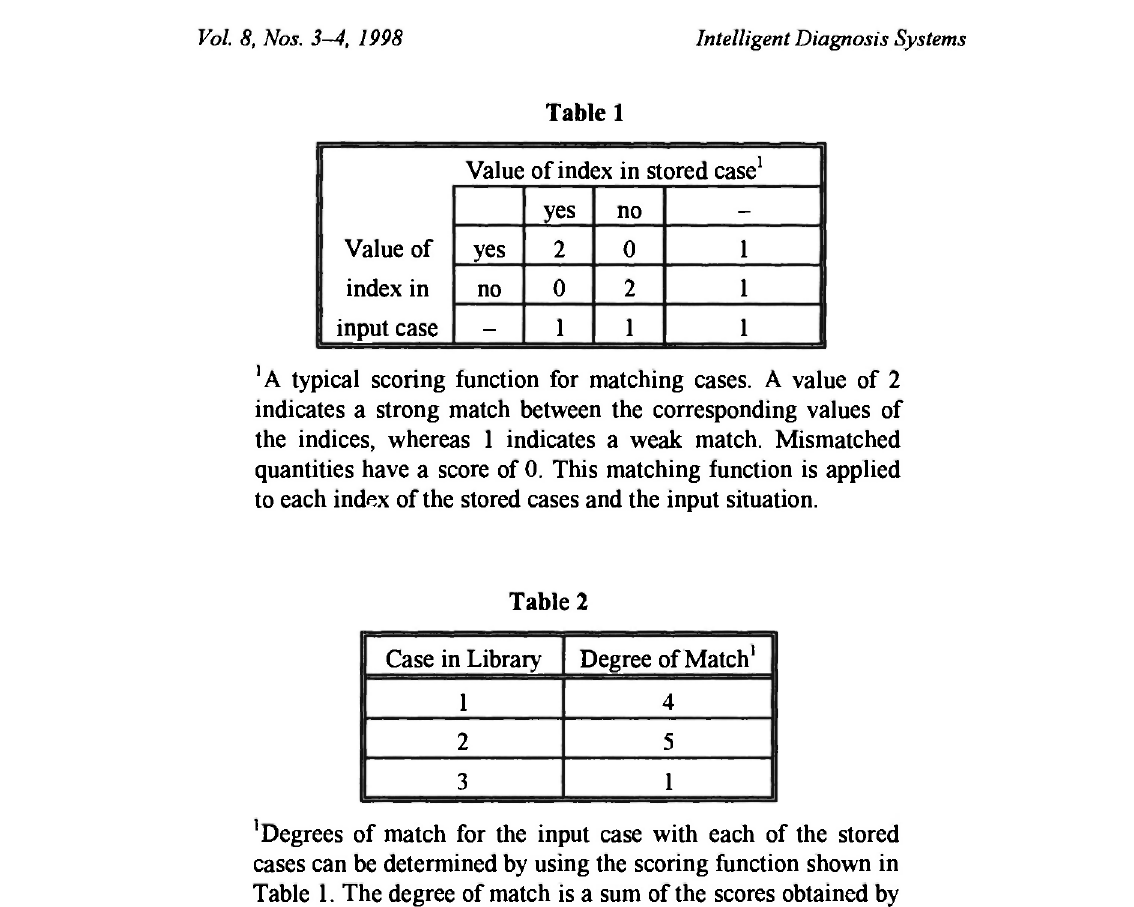
Value of index in stored case 1